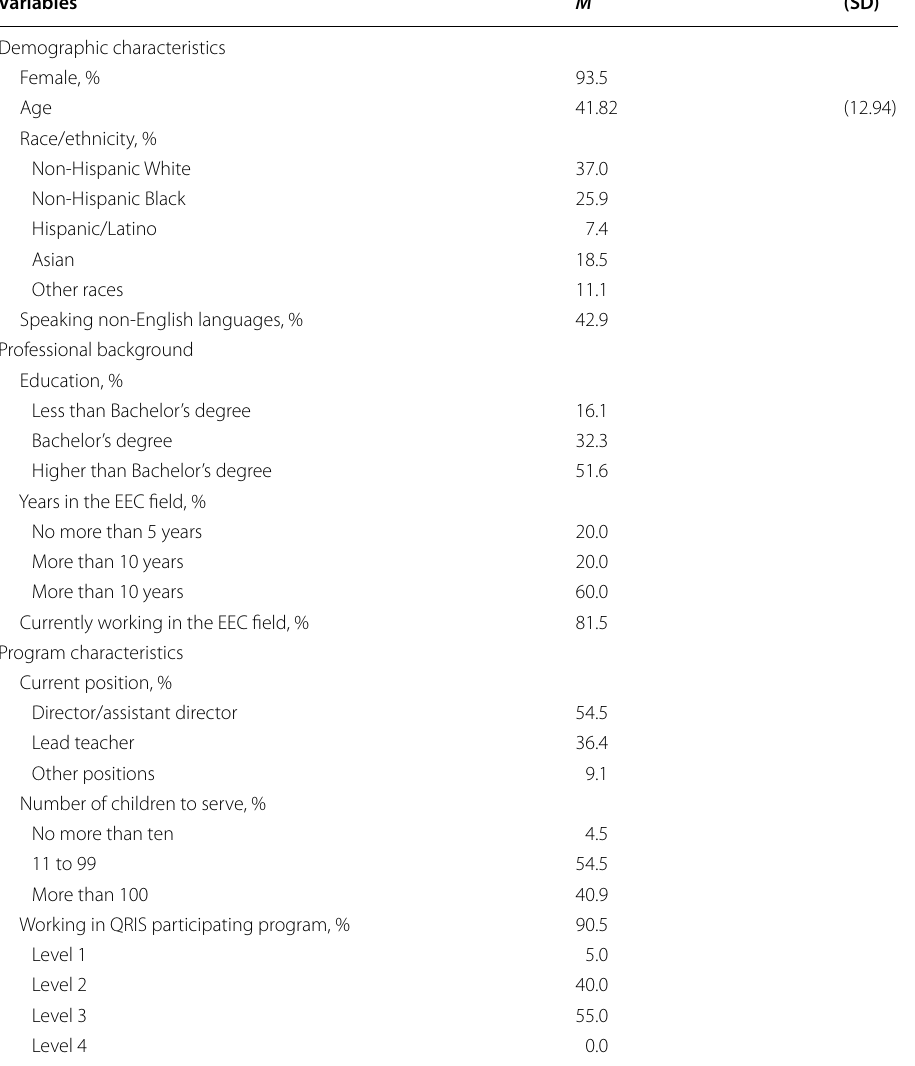
Table 1 Background characteristics of study